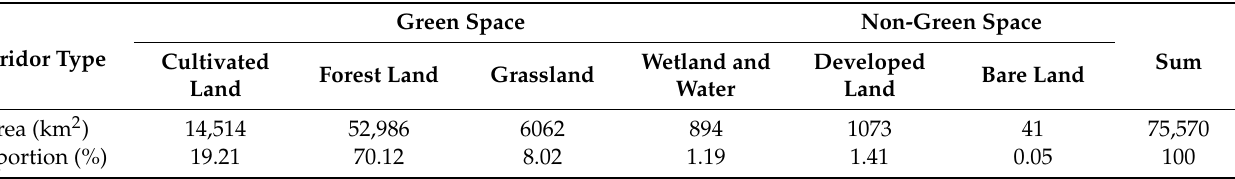
Table 4. Area proportion of the types of green spaces in ecological corridors of Fujian. Green Space Non-Green Corridor Type